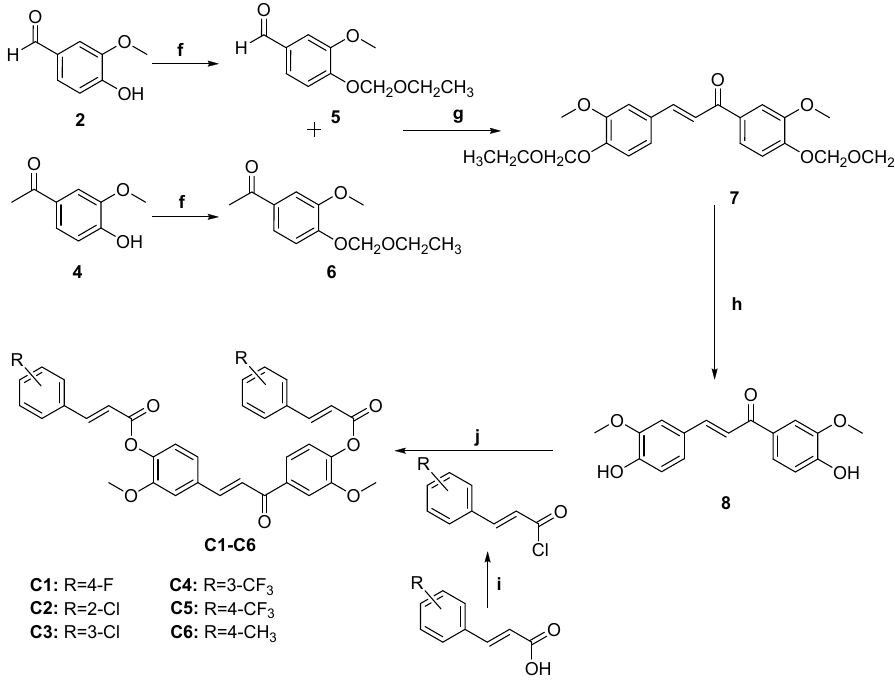
Scheme 3. Synthesis of the curcumin analogs C1–C6 . Reagents and conditions: ( f ) chloromethyl ethyl ether, DIEA, CH 2 Cl 2 , 12 h; ( g ) aqueous NaOH, ethanol, 48 h; ( h ) concentrated hydrochloric acid, methanol, 12 h; ( i ) SOCl 2 , 80 ◦ C, reflux, 2 h; ( j ) CHCl 3 , triethylamine, 0 ◦ C to room temperature, 12